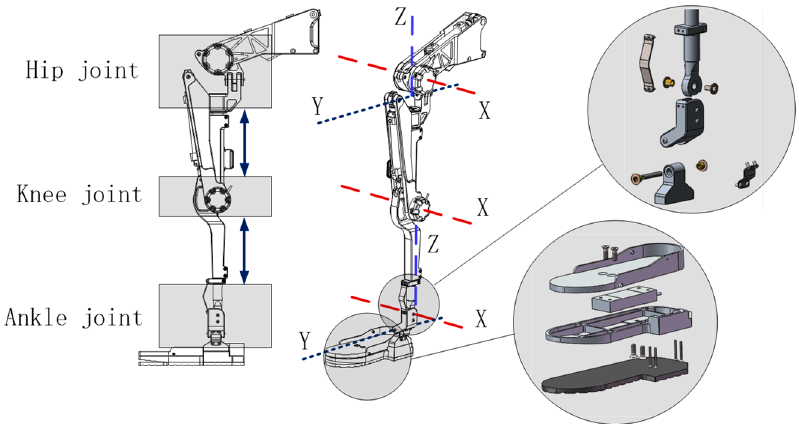
Figure 8. Structure design.